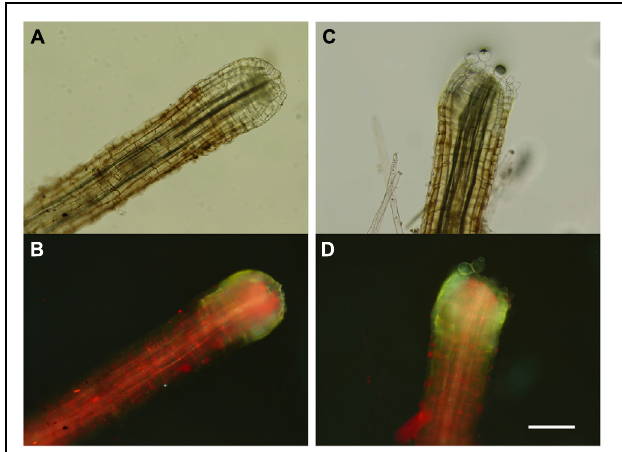
FIGURE 2 | Effect of combined treatment with nitrite and hydrogen peroxide on proximal root ends. Representative proximal ends of A. pinnata roots from plants were (A , B) untreated and removed from the frond by pulling or (C , D) dropped following simultaneous treatment with 2 mM